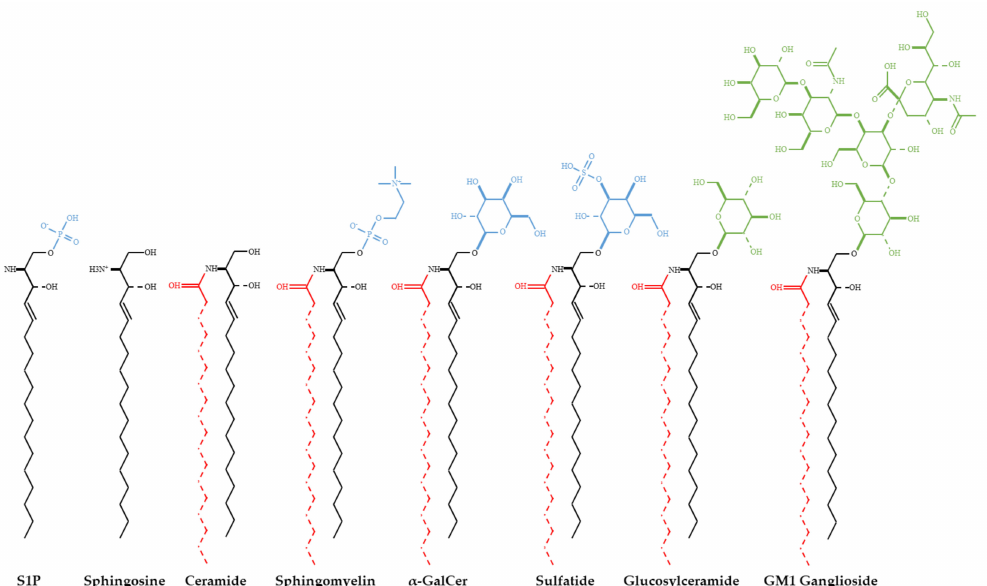
Figure 1. Sphingolipid structures. Ceramide consists of a sphingosine backbone (black) and one of several fatty acids (red), which differ in chain length and degree of saturation. Thus, the term “ceramide” actually describes a whole class of molecules. The addition of certain, invariant polar head groups (blue) results in sphingolipid classes that only vary in their underlying ceramide, whereas the addition of variable sugar groups (green) results in different glycosphingolipids. These are the most complex group, as the type and linkage of sugar residues added differ in addition to the fatty acid chain.